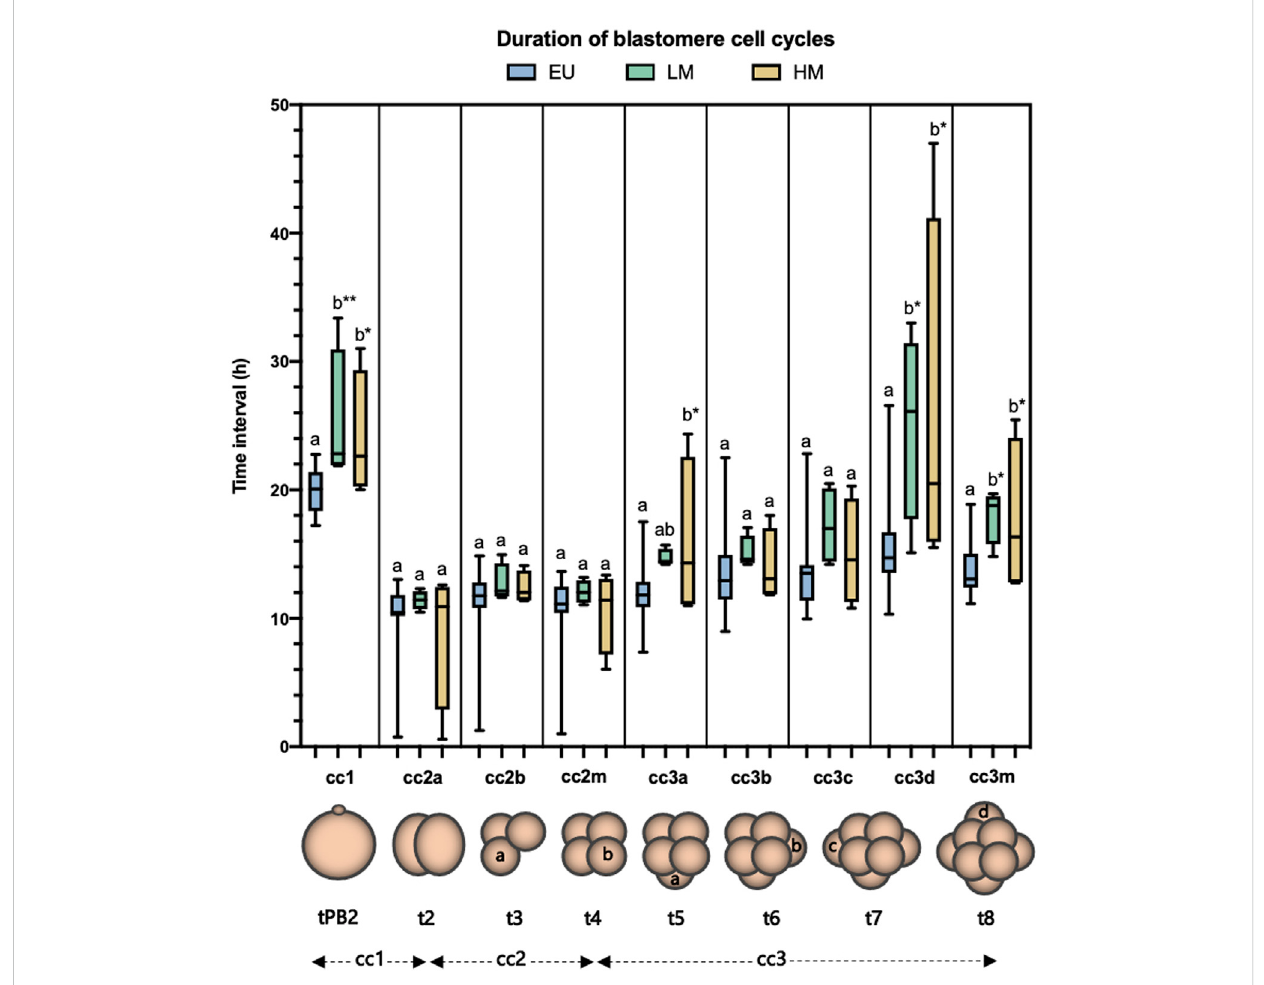
FIGURE 5 Analysisofthedurationofblastomerecellcycles.Blastomerecleavagewastrackedineuploidembryos(EU)( n =25),low-levelmosaicembryos(LM) ( n = 4) and high-level mosaic embryos (HM) ( n = 4). Box plot shows median, fi rst and third quartiles, minimum, maximum and mean values. The same letters for each parameter indicate homogeneous subsets. * p ≤ 0.05; ** p ≤